Question: Which kind of chart has been used to present this data?
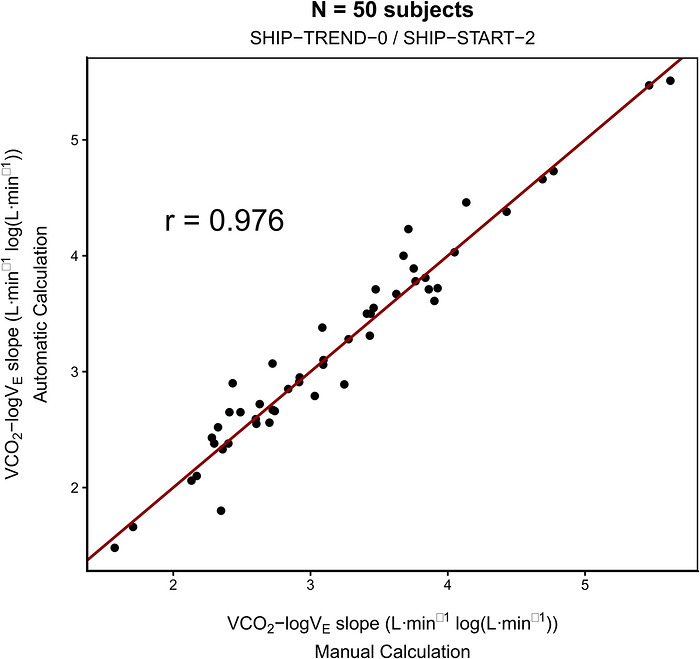
Answer: scatter